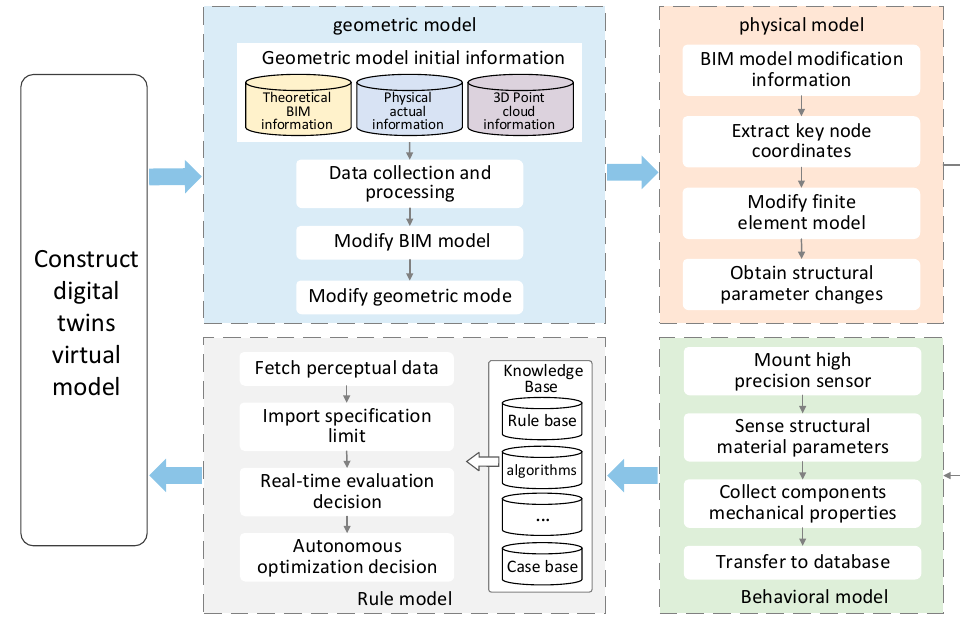
Figure 6. Construction of high precision DT S model.